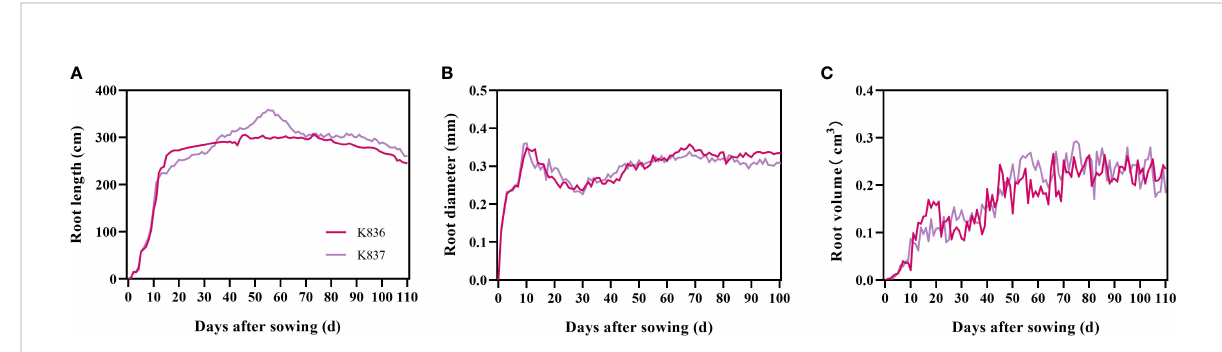
FIGURE 6 Dynamic characteristics of root phenotypes of two cotton varieties. (A) Root length, (B) root diameter, and (C) root volume.